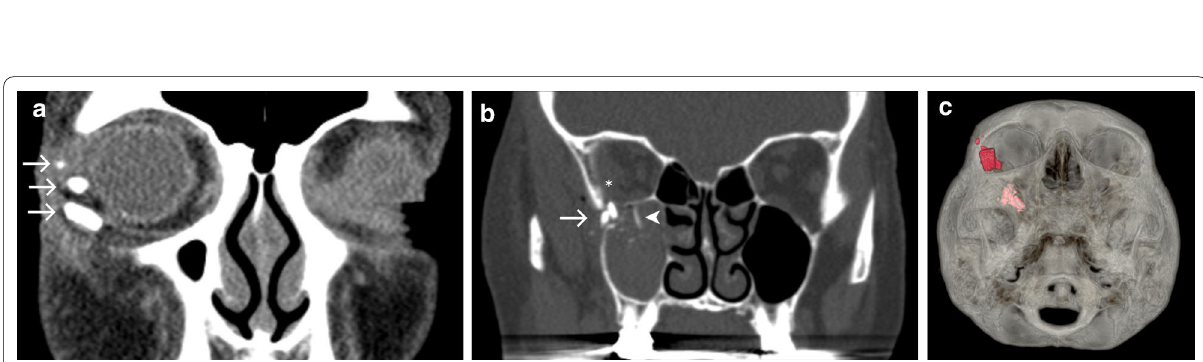
Fig. 12 Broken water glass. Coronal CT sections ( a , b ) and 3‑dimensional volume rendering ( c ) displaying intraorbital hyperdense foreign objects (arrows) in close proximity to the globe and the inferior oblique muscle ( a ) and inside the infratemporal fossa, protruding into the maxillary sinus and orbital cavity ( b ). Pronounced hyperdensity of the glass objects enables their differentiation from dislocated bone fragments (arrowhead). Also note intraorbital‑subperiosteal haematoma